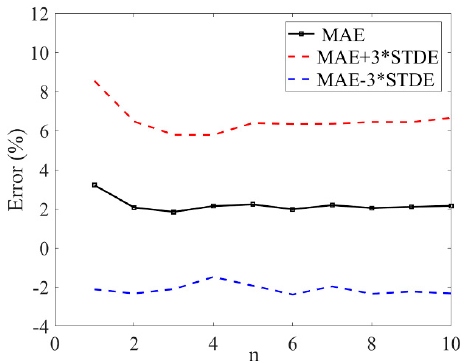
Figure 10. MAE and the upper and down limitation as a function of switching number: n.